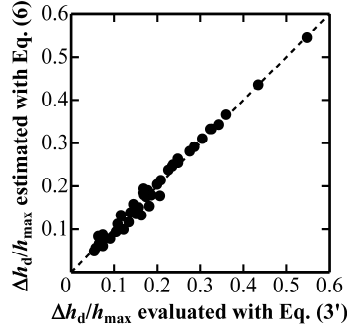
Figure 4. Degree of elastic deformation of conical indenter Δ h d / h max estimated with Equation (6) plotted against Δ h d / h max evaluated with Equation (3’). In order to estimate mechanical properties from a P - h curve characterized with k 1 , k 2 and ξ , we should know the inclined face angle β d of the elastically deformed indenter. Numerical analysis revealed that β d is given as a function of β o , ξ n and Δ h d / h max